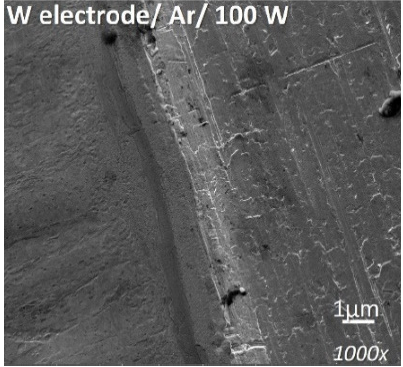
Figure 13. Margin zone_SEM images of W surface electrodes exposed to Ar-MD.